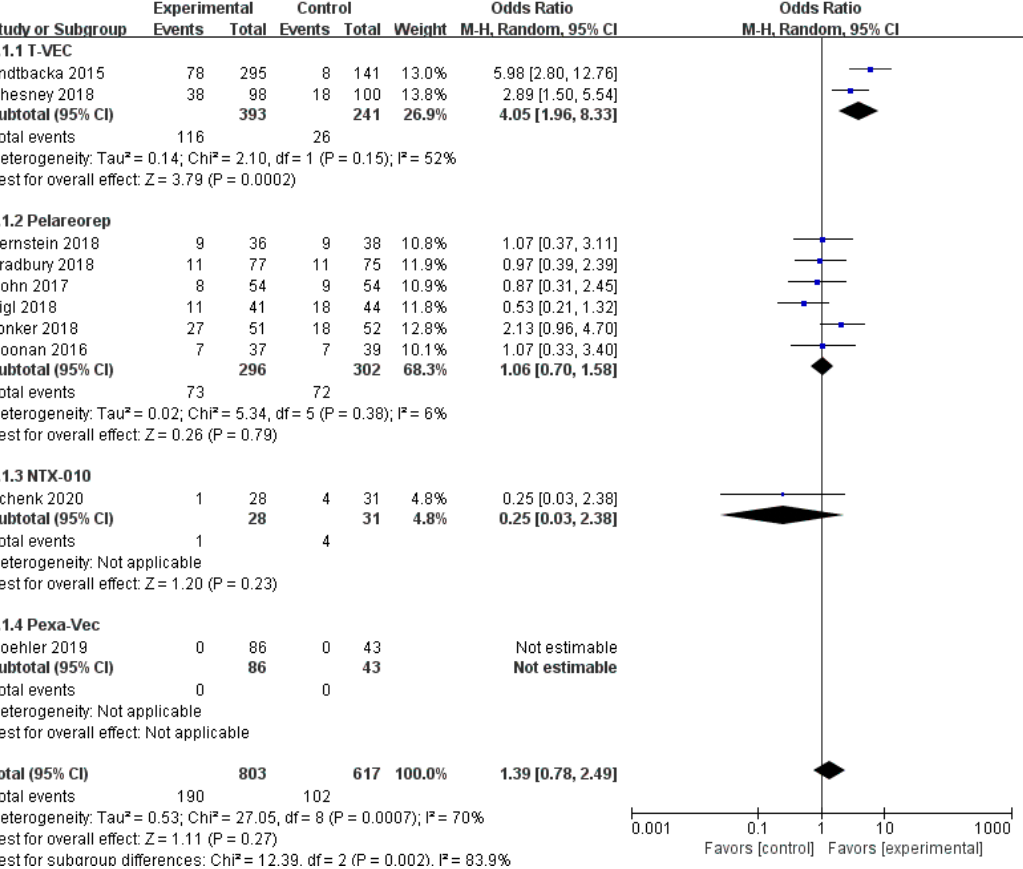
Figure 3. Forest plot of the pooled odds ratios (ORs) for objective response rate (ORR) in different oncolytic virus species.